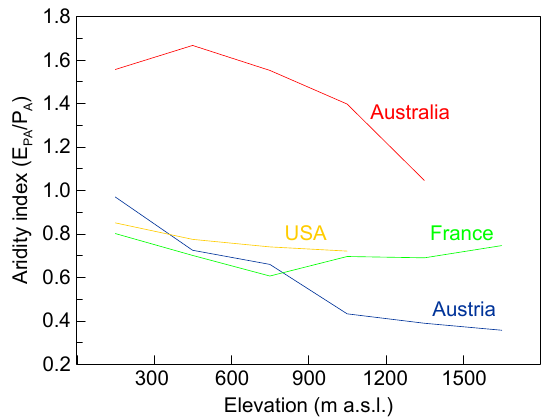
Fig. 8. Aridity index as a function of mean catchment elevation for the studies used in Level 2 assessment (Table 1). The aridity repre- sents the median over all catchments in a particular elevation class.